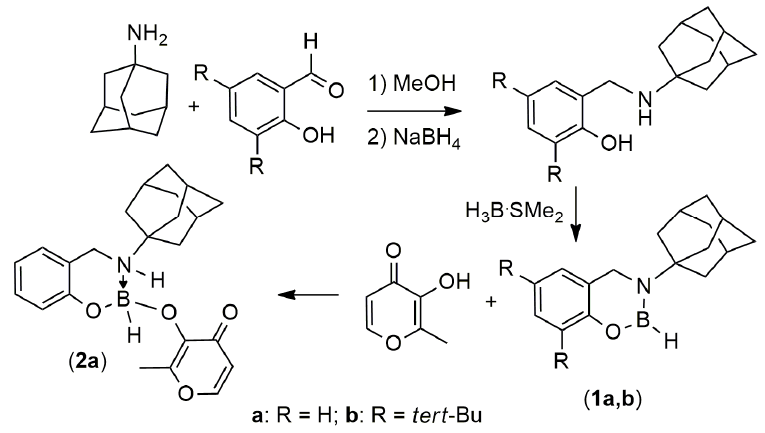
Figure 2. Synthesis of novel oxazaborinanes 1a , b and their reactivity with